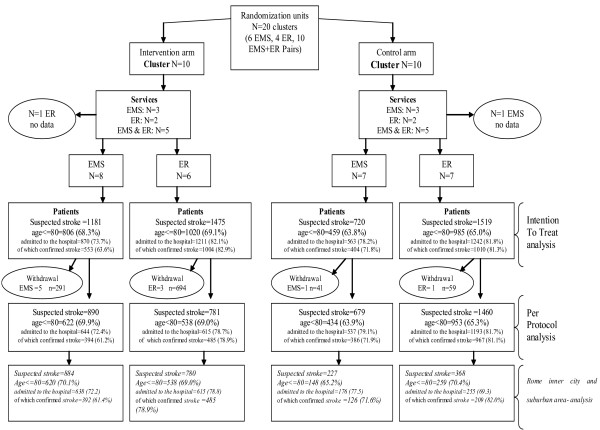
Flowchart of randomisation procedures and cohorts of enrolled patients. The figure describes the entities' randomization results, with the description of cohorts of patients involved in the trial.